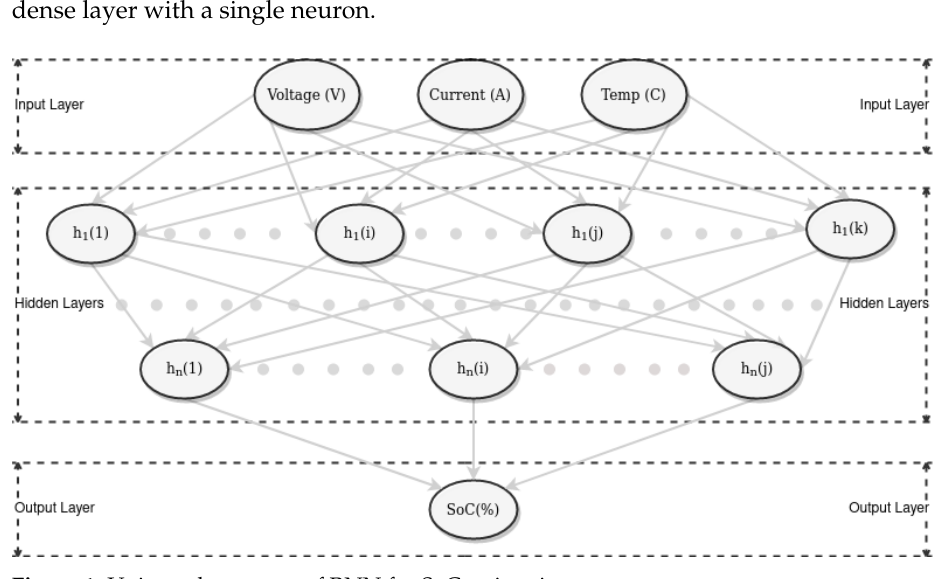
Figure 1. Universal structure of RNN for SoC